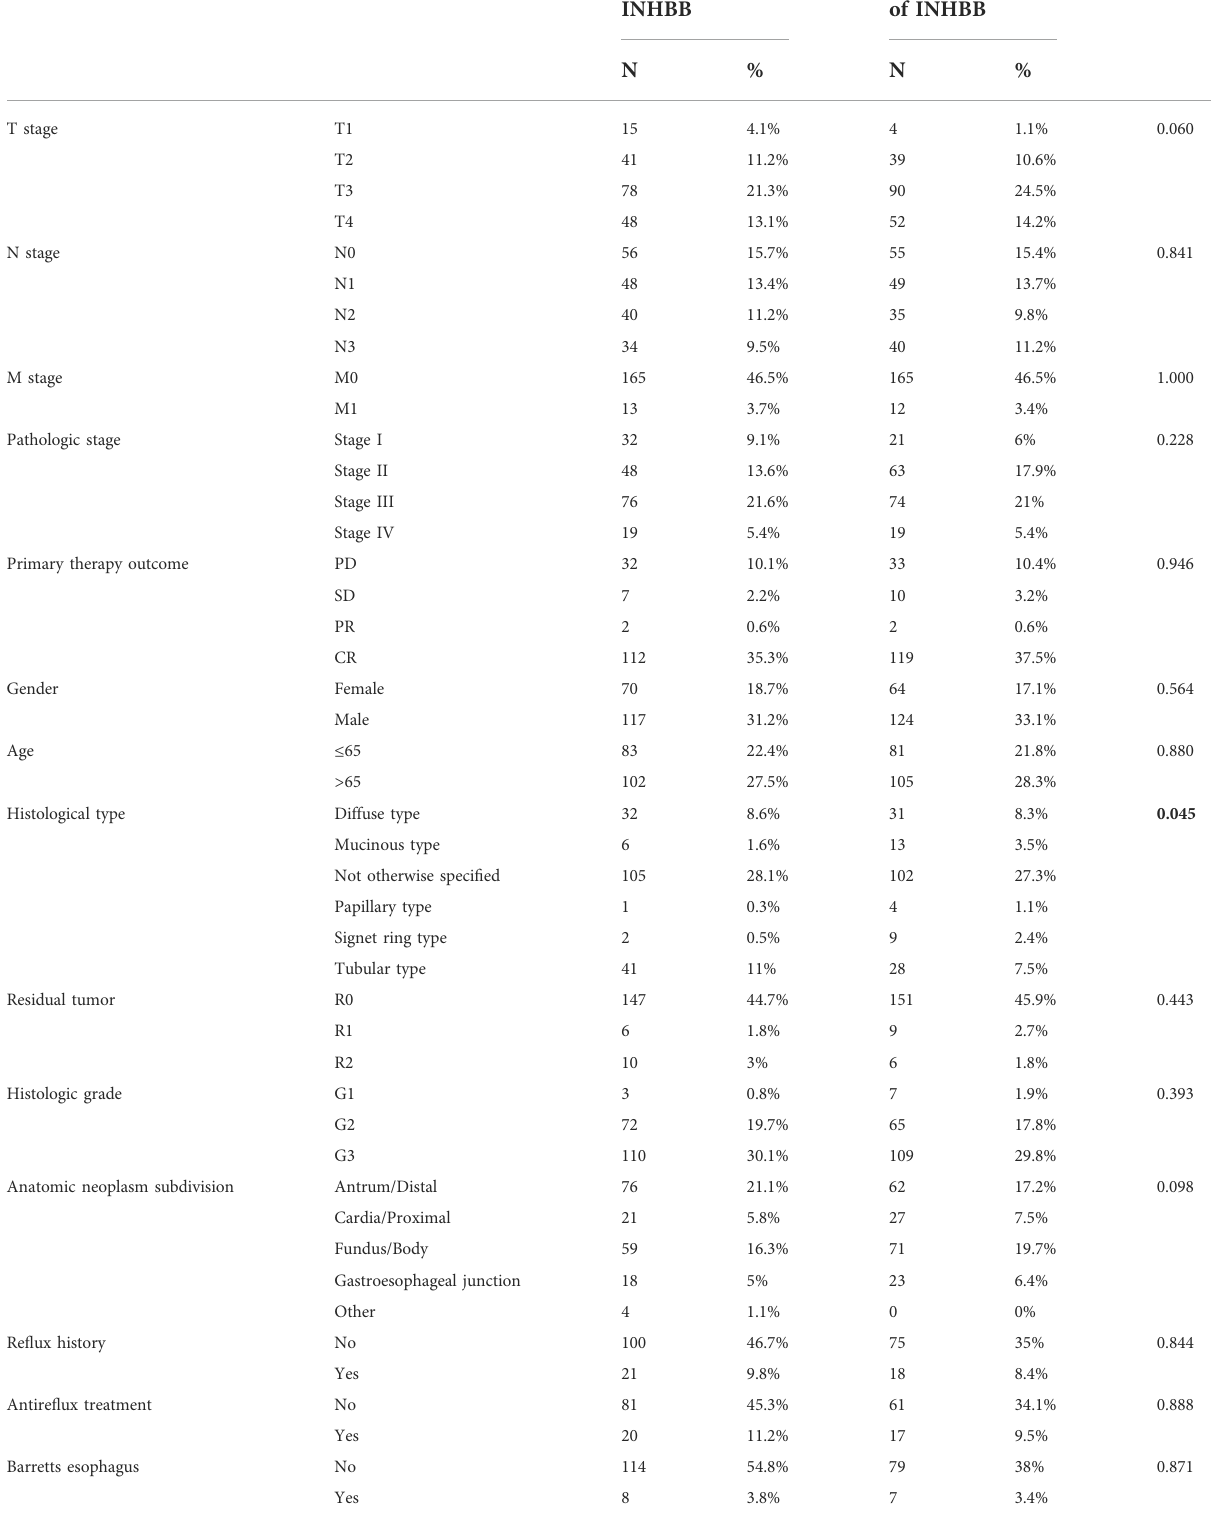
TABLE 1 Clinical characteristics of patients with GC based on TCGA.